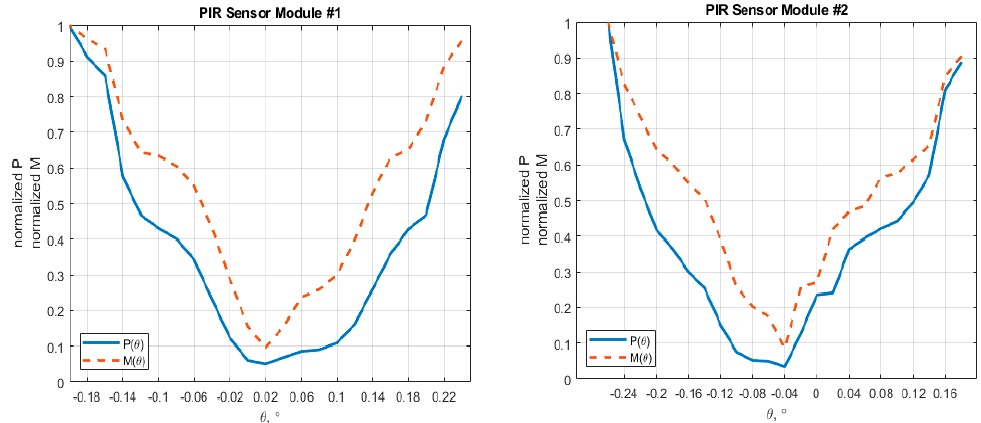
Figure 9. Experiment results of normalized PSD and magnitude at modulation frequency over dif ‐